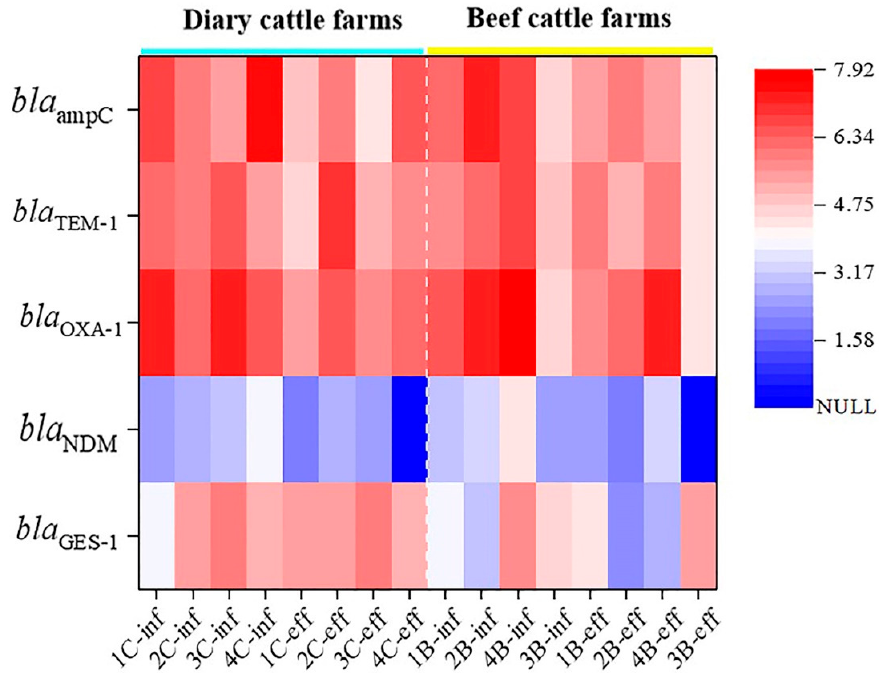
Figure 4. Heat maps of the absolute abundance of bla genes in raw influent (-inf) and final effluent (-eff) from dairy cattle and beef cattle farms.